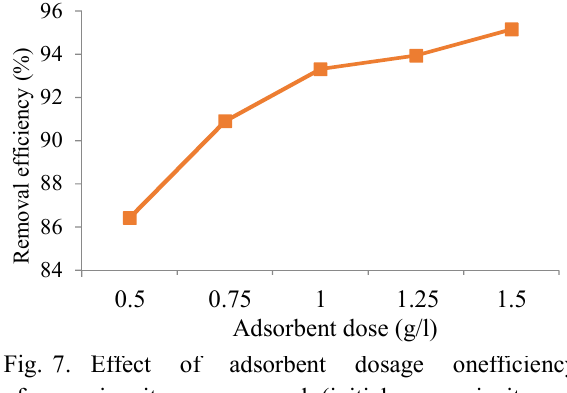
Fig. 7. Effect of adsorbent dosage onefficiency ofammonia nitrogen removal (initial ammonianitrogen concentration of 150 mg/L, contact time of 120 min and